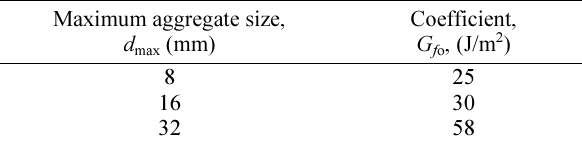
Table 3. Aggregate size-based fracture coefficients (Rots 1988) Maximum aggregate